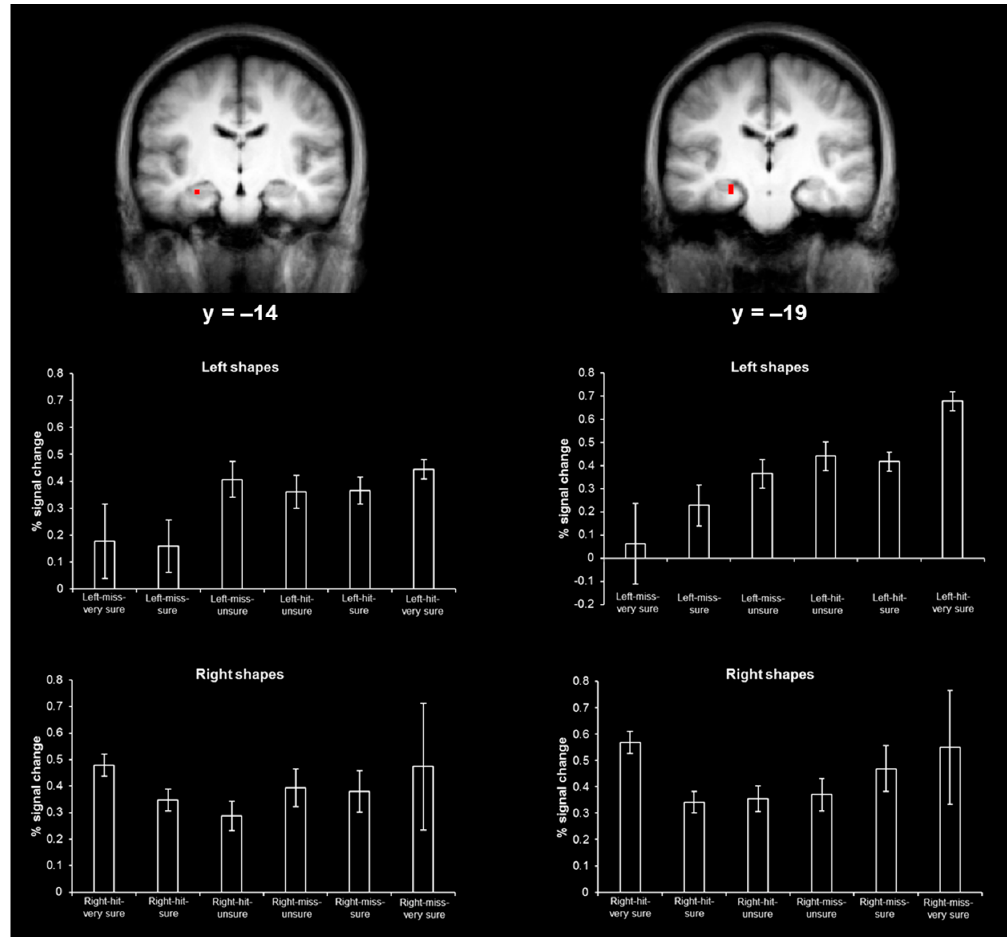
Figure 4. Hippocampal activity associated with spatial memory and hippocampal activity distributions. Top , hippocampal activity associated with left-hits versus left-misses (in red; coronal views). Bottom , hippocampal activity distributions (percent signal change for each event type) for left-shapes and right shapes corresponding to each hippocampal activation above.